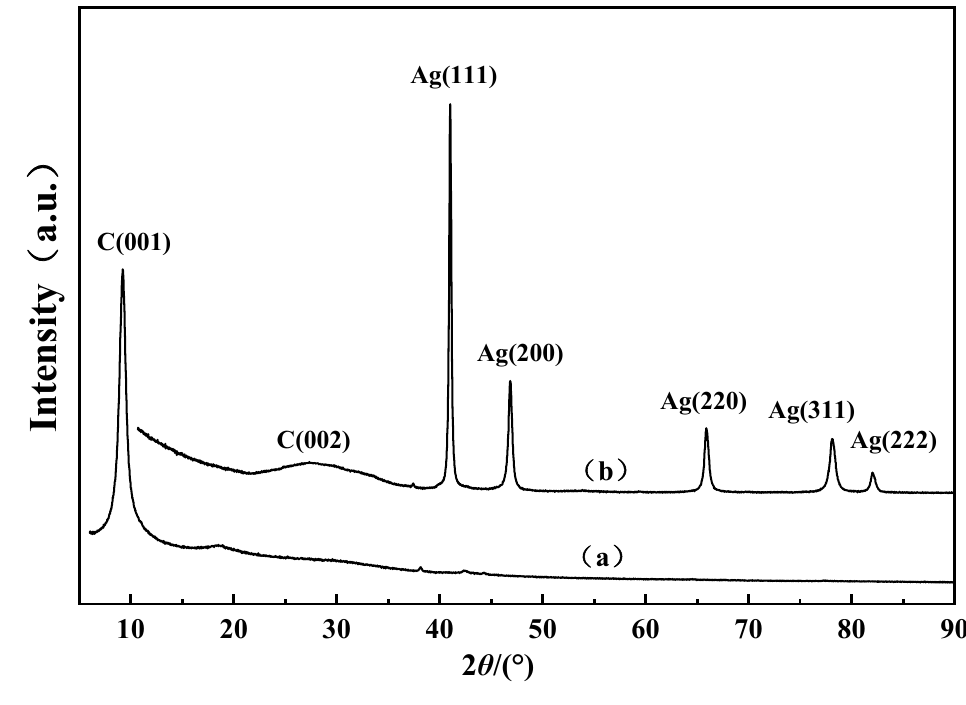
Figure 2. XRD patterns of (a) GO and (b)